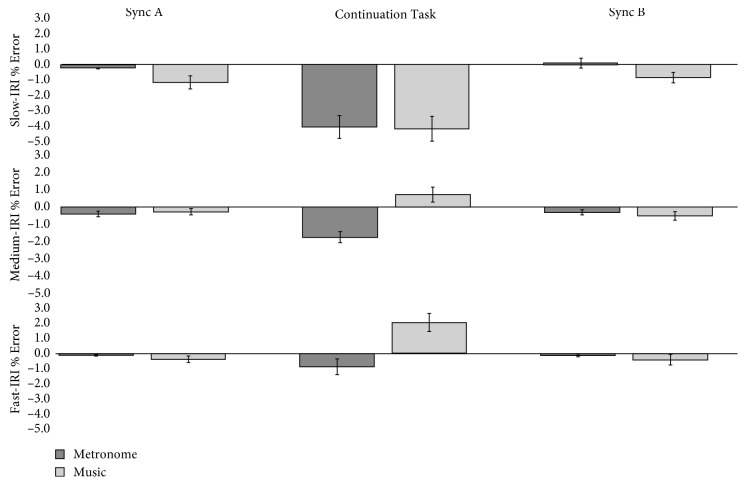
The main effect of cue type on entrainment ability (IRI % Error) collapsed across all groups in each tempo. Y-axis shows IRI % Error. X-axis shows the temporal nature of the experimental paradigm.